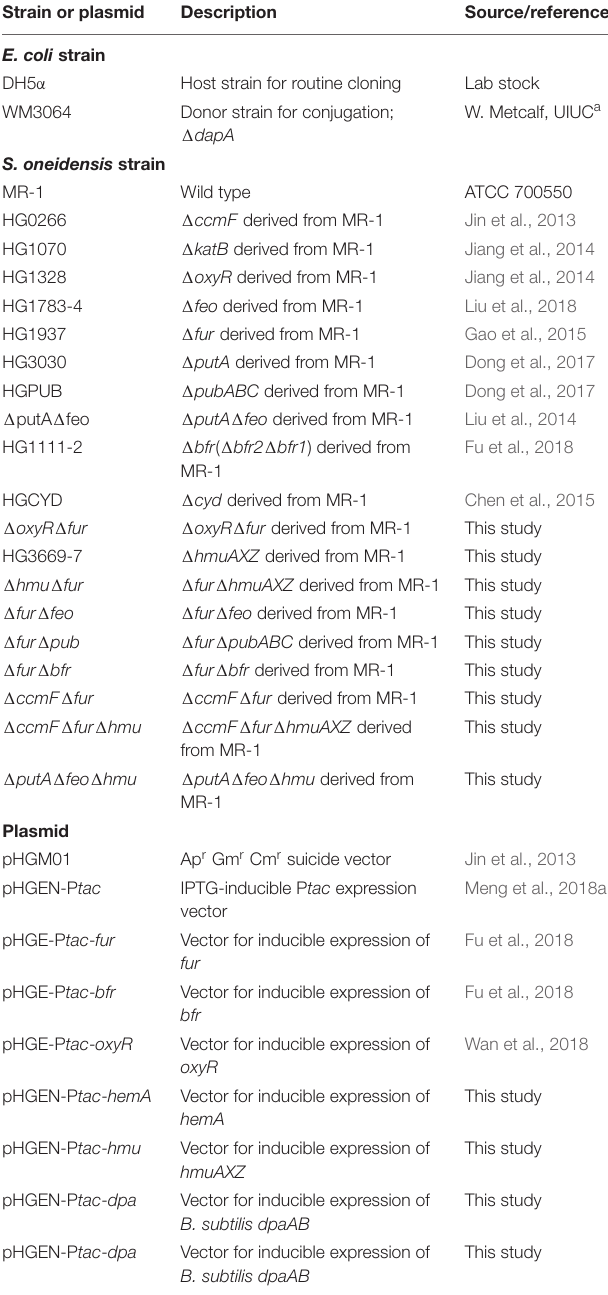
TABLE 1 | Strains and plasmids used in this